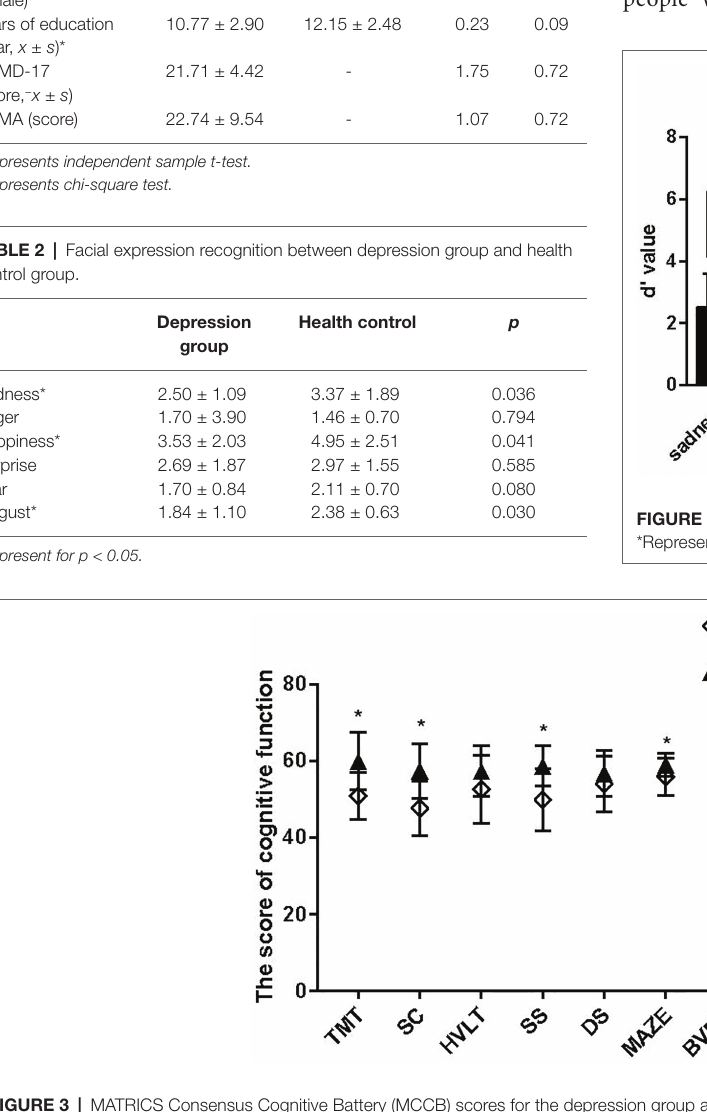
FIGURE 3 | MATRICS Consensus Cognitive Battery (MCCB) scores for the depression group and control group. *Represent for p < 0.05.